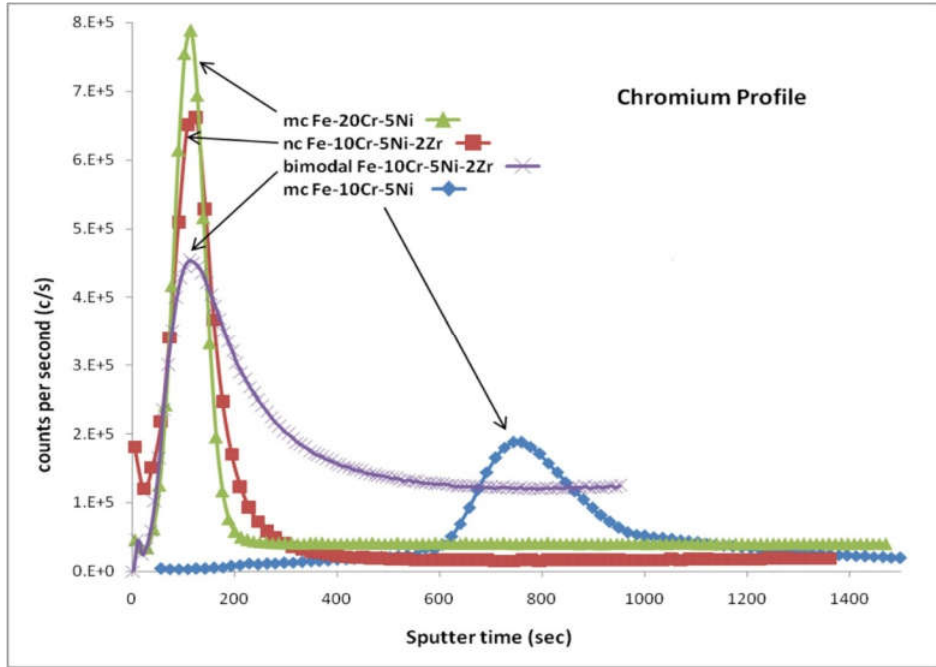
Figure 9. Cr depth profile for oxidised alloys described in Figure 8 (above) measured using secondary ion mass spectroscopy (SIMS). ([33], reproduced with copyright clearance).